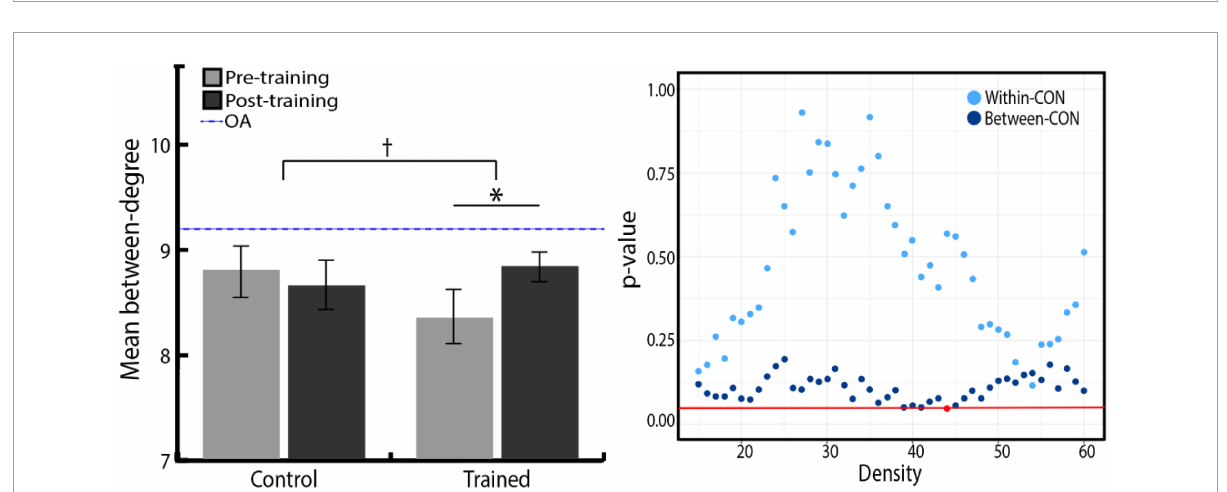
FIGURE5 (Left) Density-averaged between-CON degree in both groups, before and after training. Between-CON degree significantly increased in the training group (* p < 0.05), although the increase was not significantly greater compared with the control group ( † p < 0.10). There was no significant difference between the two groups in initial between-CON degree ( p = 0.201). The blue dashed line represents between-CON degree of older adolescents from ADHD-200 dataset. Error bars indicate the SEM. (Right) P -value distribution for Group × Time ANOVA of the CON within and between degree across network densities. The red line indicates a p -value of 0.05, and red dots indicate the densities at which the difference in the degree change between two groups is